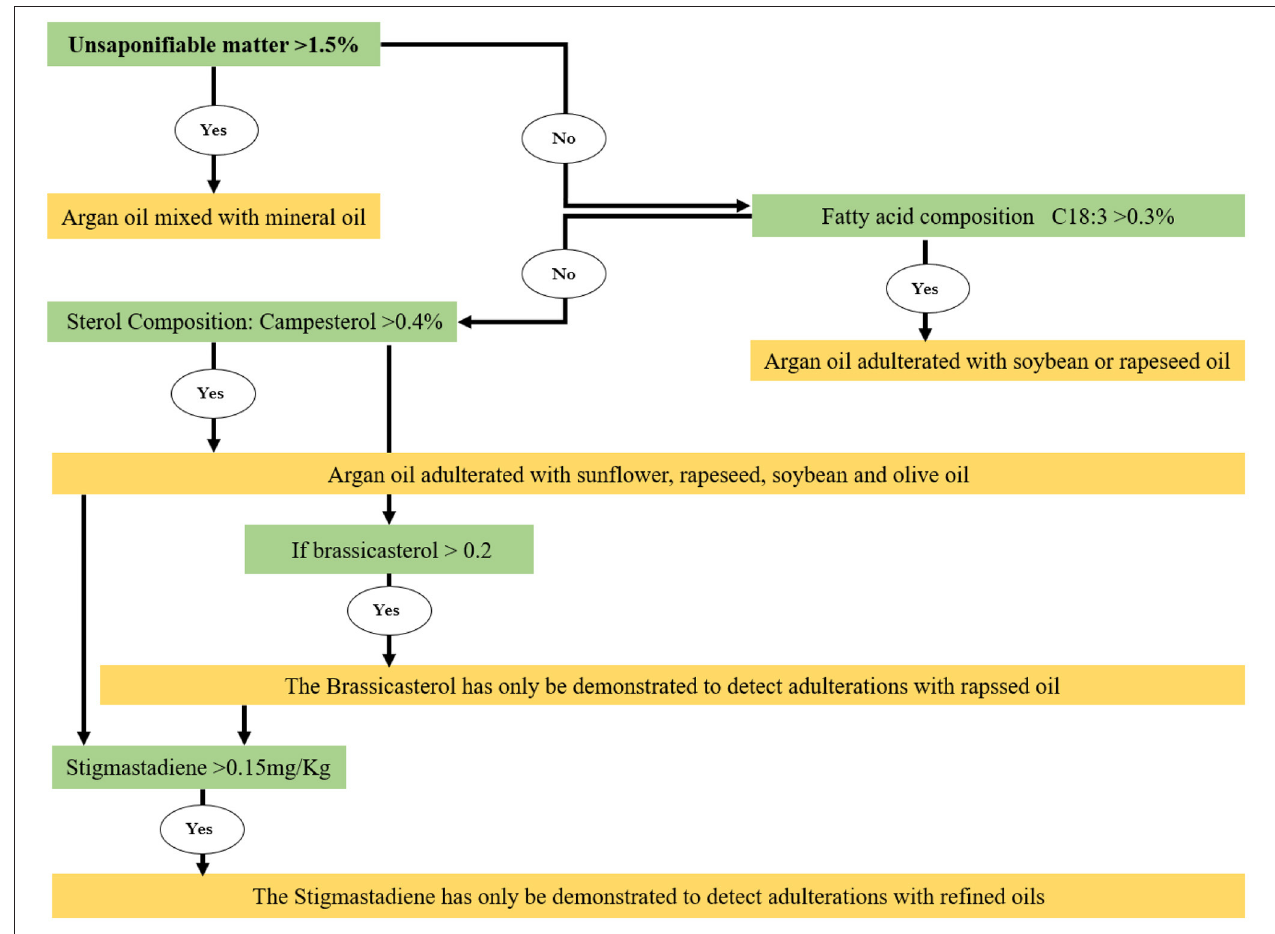
FIGURE 5 | Scheme of the main analytical methods for determination of argan oil adulteration by vegetable